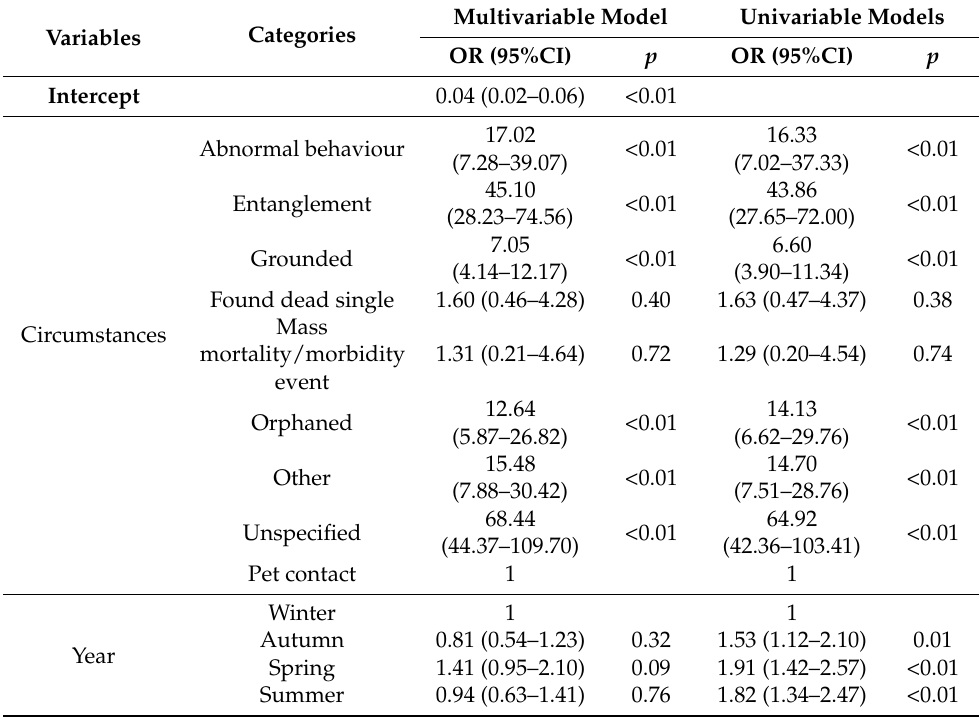
Table 6. Effects of circumstances and year on probability of human